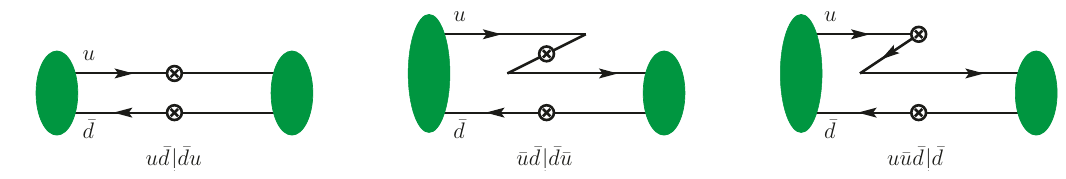
Figure 12 . Examples for the partonic regimes of graph C 1 in a π + . The notation u ¯ u ¯ d | ¯ d is the same as in figure 2, i.e. the partons to the left of the vertical bar belong to the pion on the left of the graph.